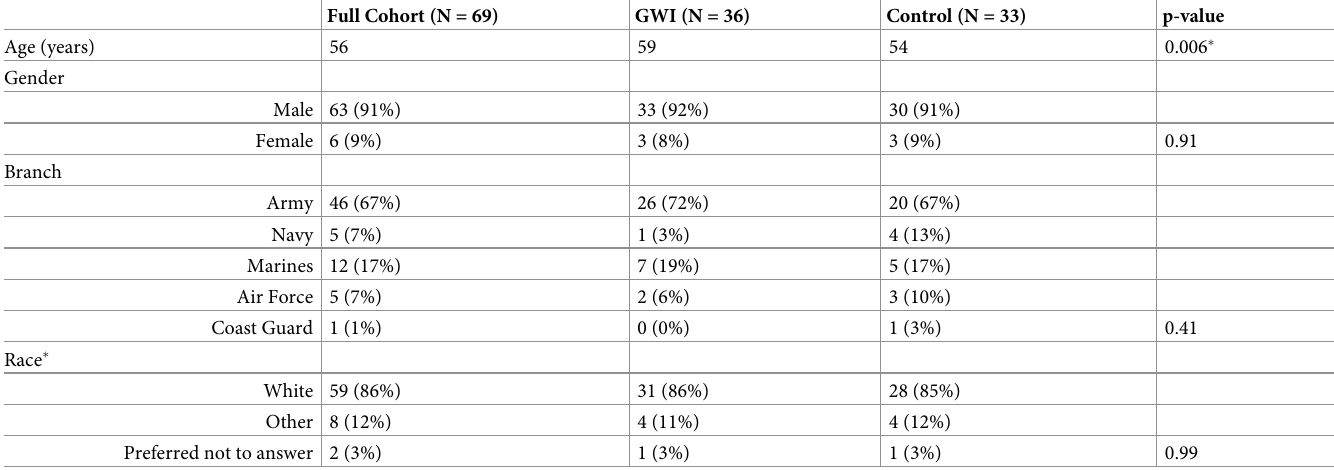
Table 2. Participant demographics by age group.